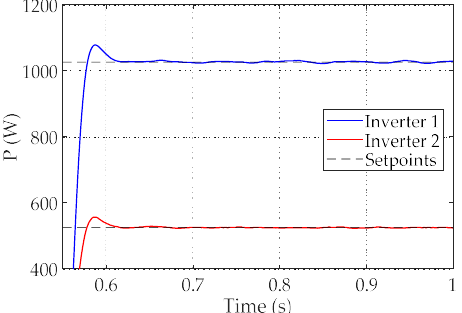
Figure 11. Output power for both prosumers.